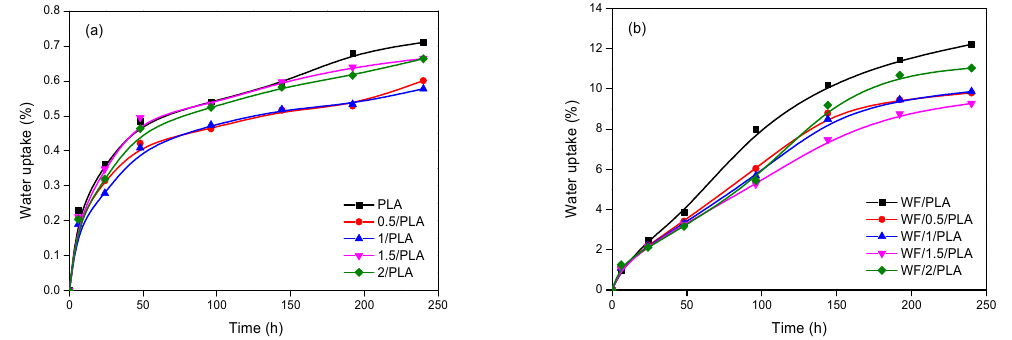
Figure 3. Water uptake of virgin and OMMT-modified PLA ( a ) and the composites ( b ).